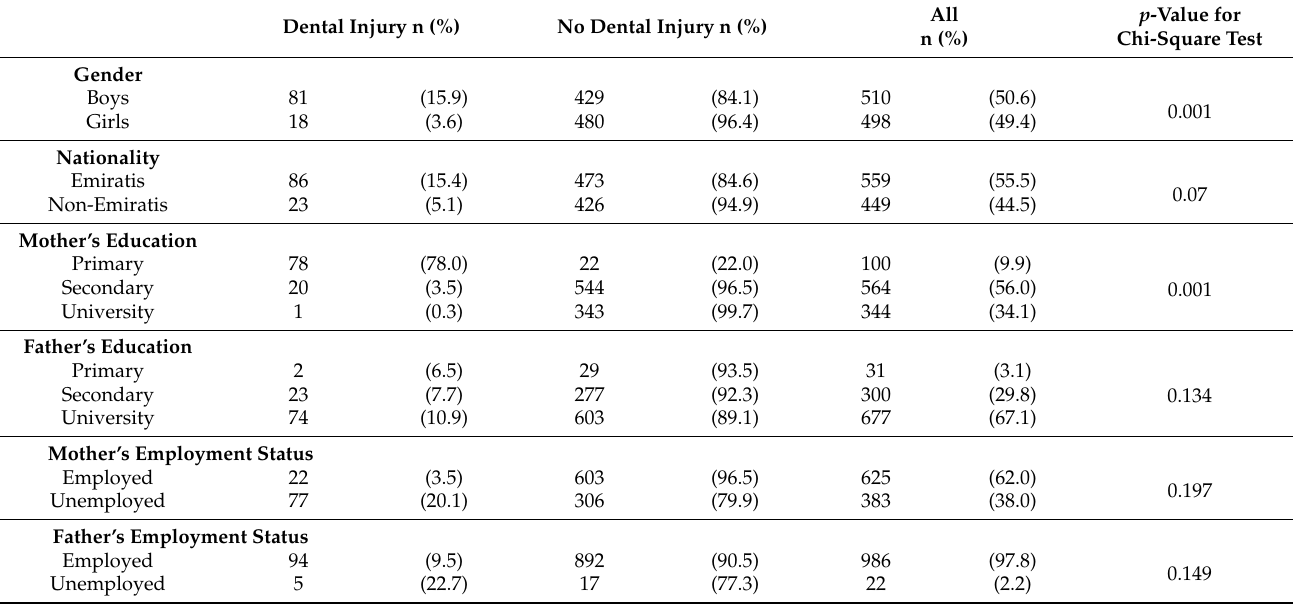
Table 1. Demographic data and distribution of permanent incisor dental injuries in the sample population of 1008